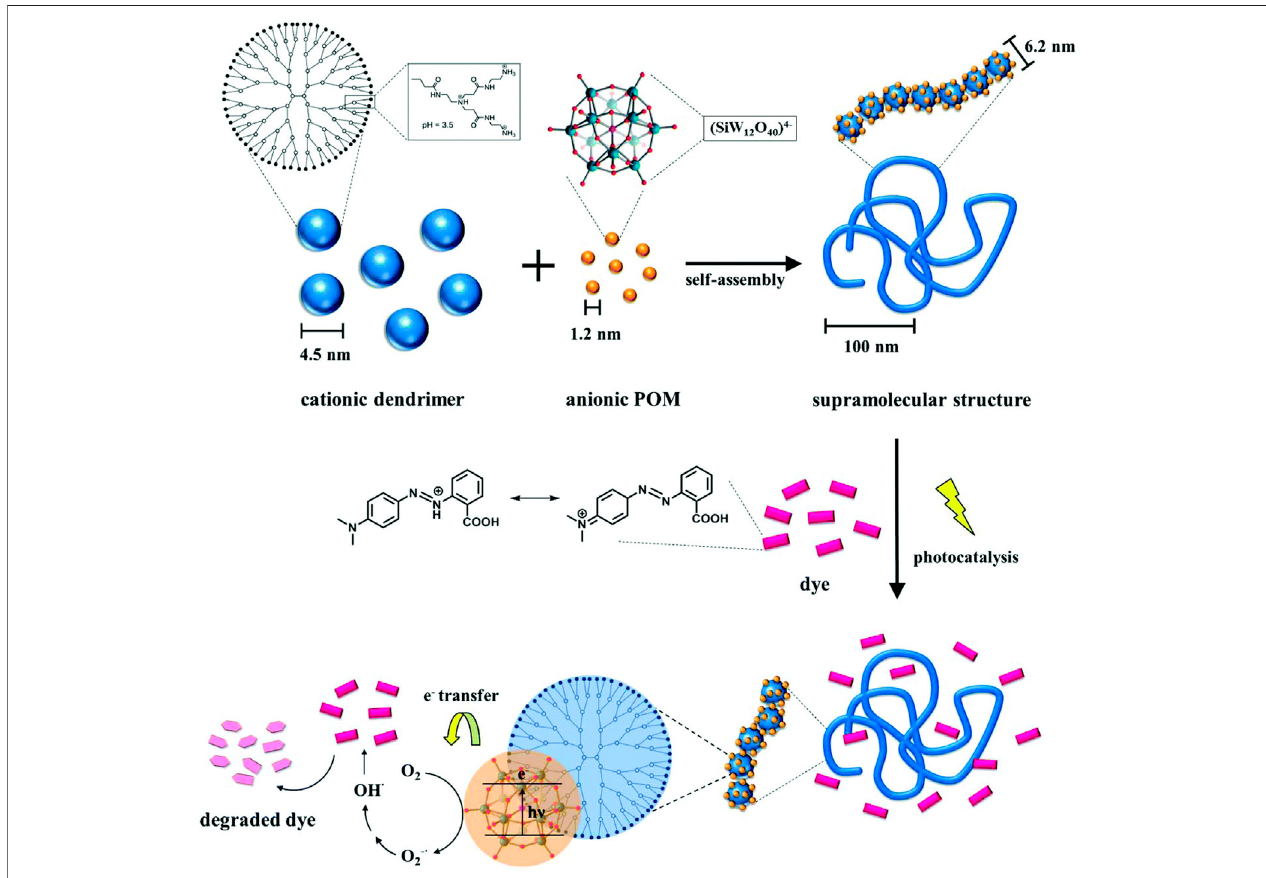
FIGURE 30 | POM – dendrimer self-assembly and photocatalysis in aqueous solution as investigated: (A) Scheme and photos of the photocatalytic degradation of methyl red by POM – dendrimer assemblies and POM in aqueous solution; A: POM – dendrimer before irradiation, (B) : POM – dendrimer after 20 min UV-irradiation, (C) : POMbeforeirradiation, (D) :POMafter 20 minUV-irradiation;Thedyedegradesmuchmore withthePOM – dendrimer assembly(A → B)ascomparedtotheclusteronly solution (C → D) (Kutz et al., 2018). Reprinted with permission. Copyright © The Royal Society of Chemistry 2018.